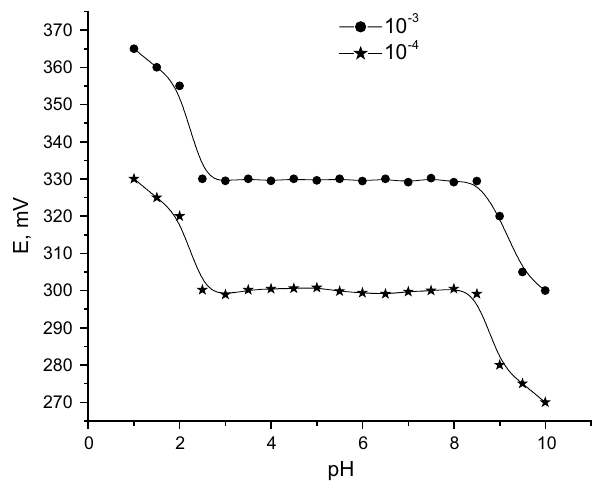
Fig. 5 Effect of pH of the test solution on the potential readings of modified SPE